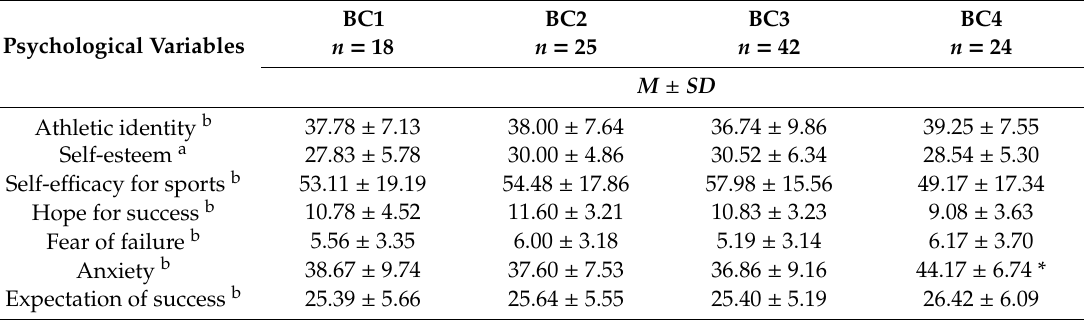
Table 2. Di ff erences in psychological variables between boccia athletes by sport classes (BC1, BC2, BC3, and BC4).